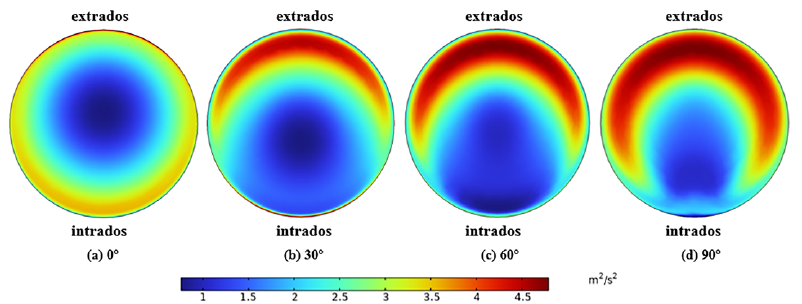
Figure 11. Section view of turbulence intensity development from 0° to 90° in the axial direction of elbow.